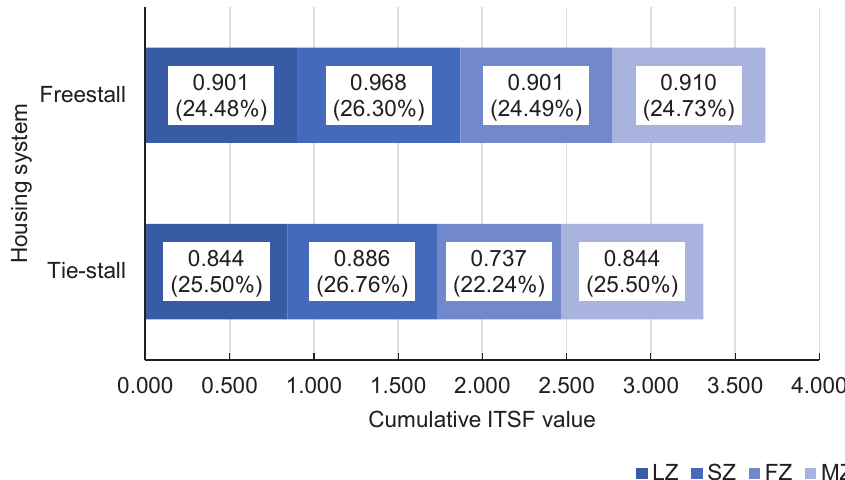
=lying zone, SZ=social zone, FZ= feeding zone, MZ=milking